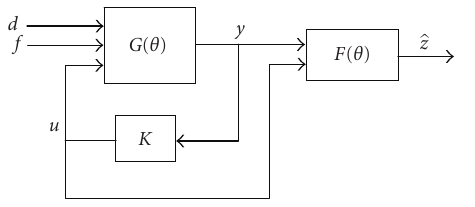
Figure 2: General setup for FDI/LPV filter design